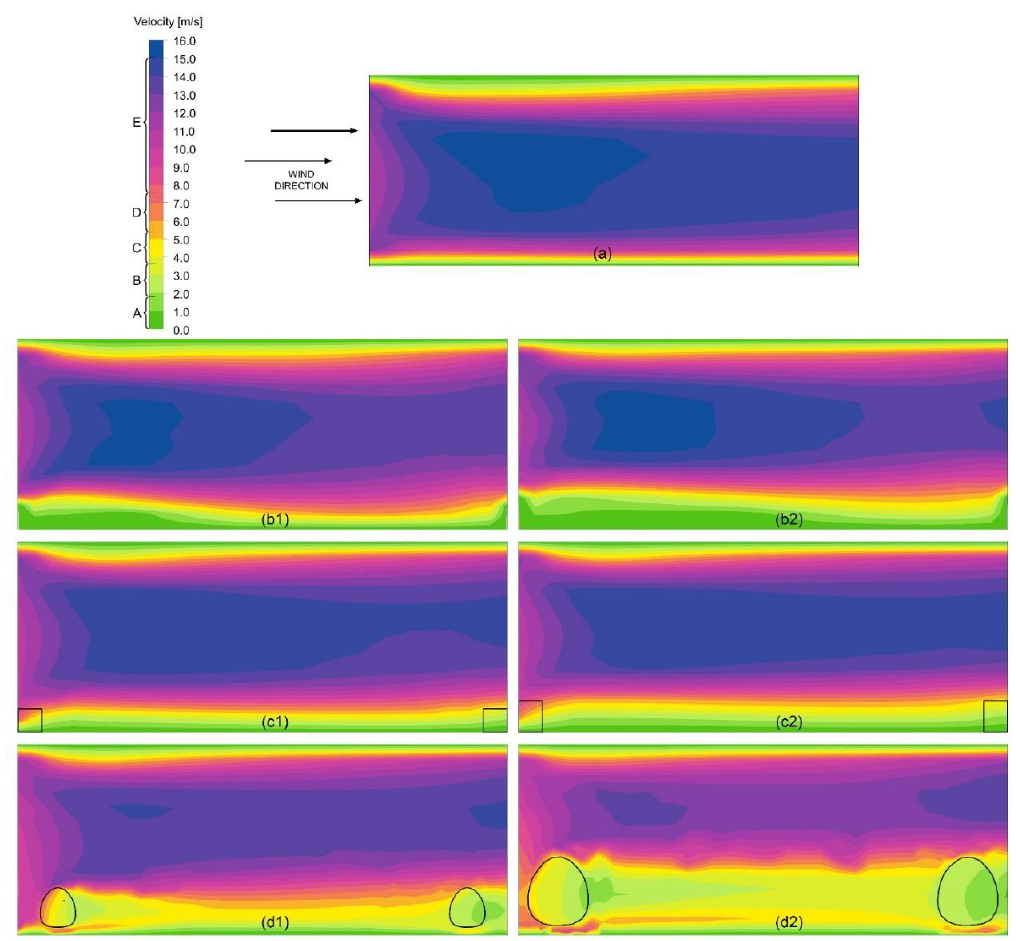
Figure 14. Plot of wind speed in the skygarden along a vertical plane; ( a ) base configuration without any buffer, ( b1 ) railing 1.5 m, ( b2 ) railing 2 m, ( c1 ) hedge 1.5 m, ( c2 ) hedge 2 m, ( d1 ) tree 2.5 m, and ( d2 ) tree 5